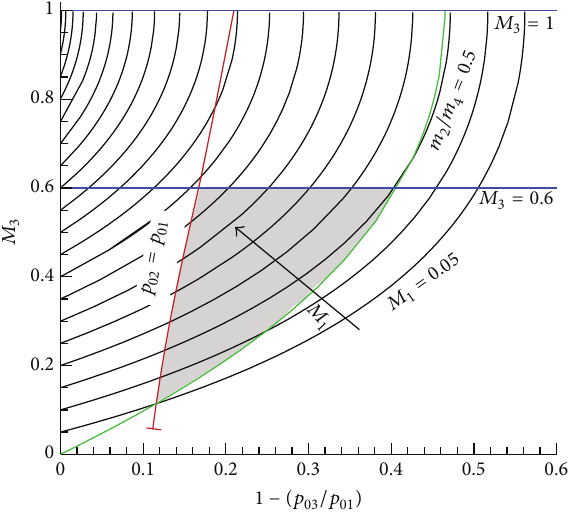
Figure 9: Target total pressure loss distribution at the AIP at a radial location 𝐷 0 /4 corresponding to Example